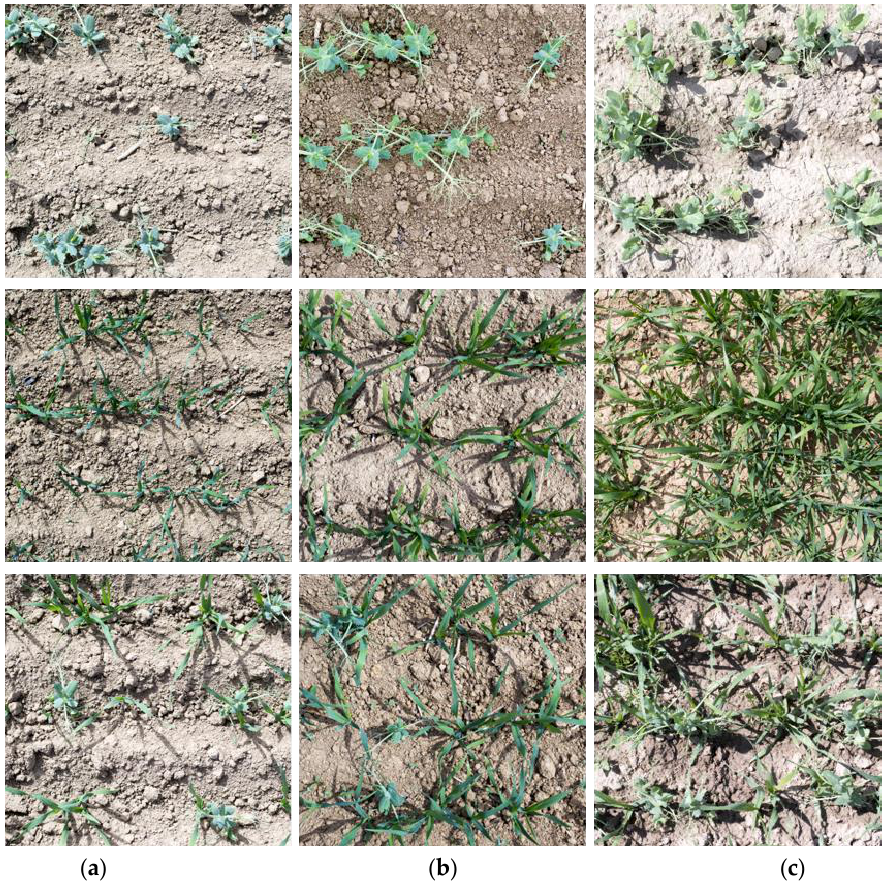
Figure 2. Exemplary images of the three datasets used for the evaluation. ( a ) Low cover dataset (25 April), ( b ) intermediate cover dataset (2 May), and ( c ) high cover dataset (16 May). From top to bottom: pea, oat, and pea – oat intercrops.